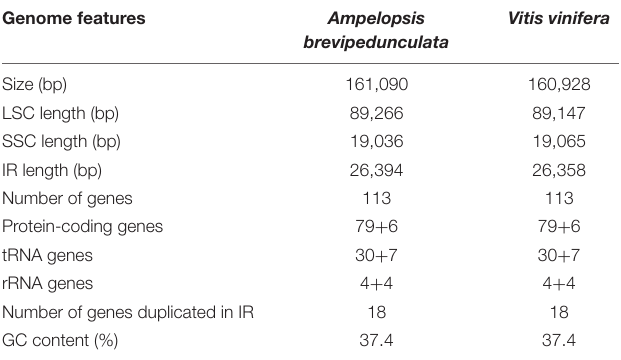
TABLE 1 | Summary of chloroplast genome characteristics of Vitaceae. Genome